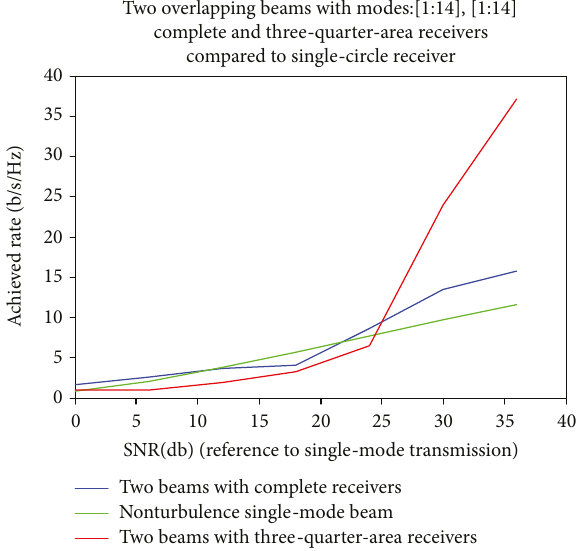
2 = 10 − 15 , 300m, L n